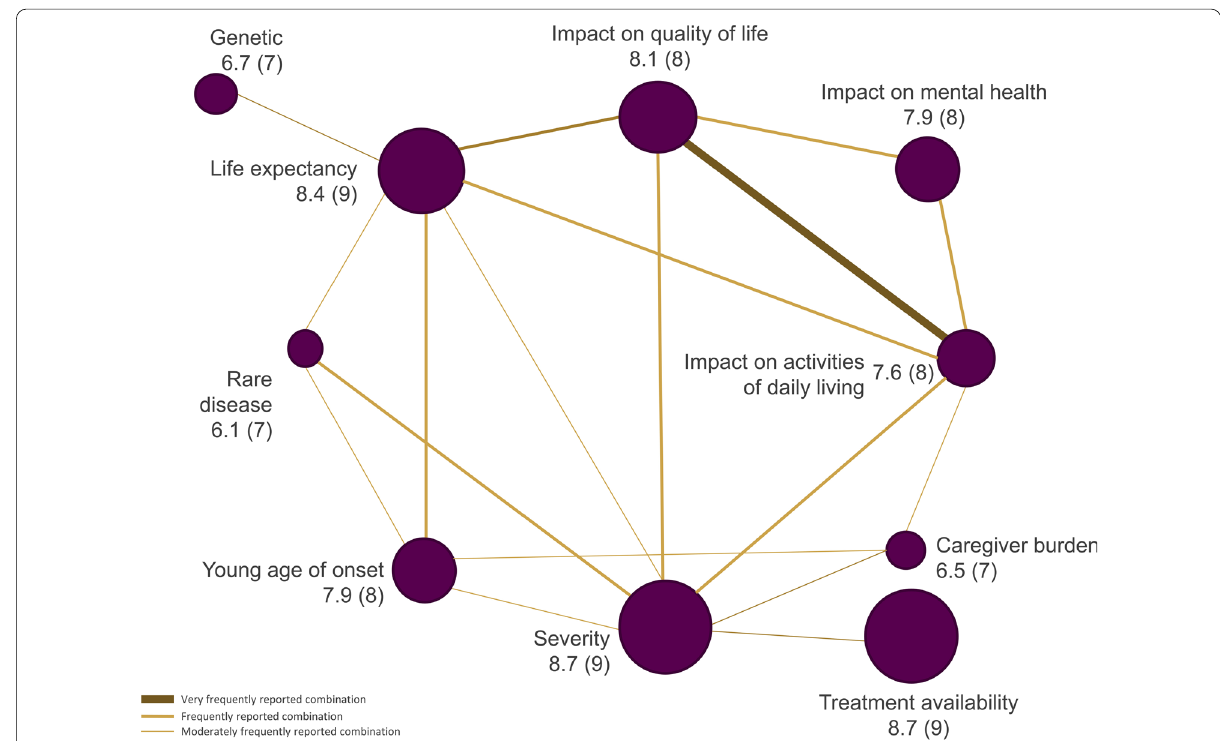
Fig. 1 Mean (median) attribute ranking, and frequency of reported relationships between attributes